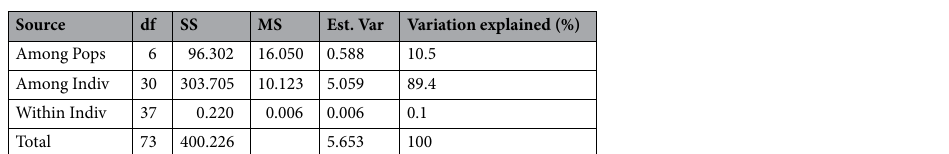
Table 3. Summary of analysis of molecular variance (AMOVA).